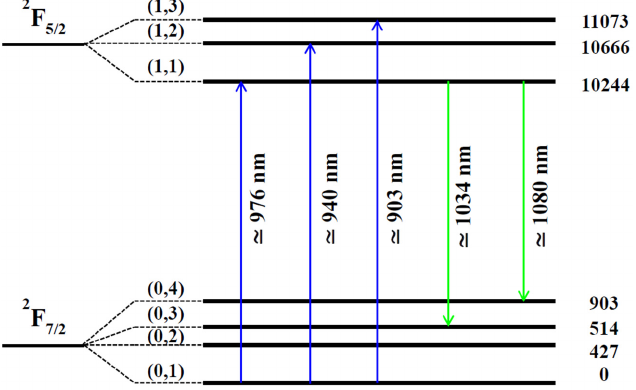
Figure 33. Energy level configuration for Yb:Lu 2 O 3 .